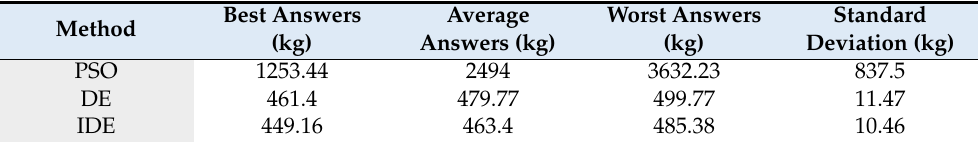
Table 12. Comparison of the proposed method with other methods for reducing gas emission with considering the limitations of upstream network power